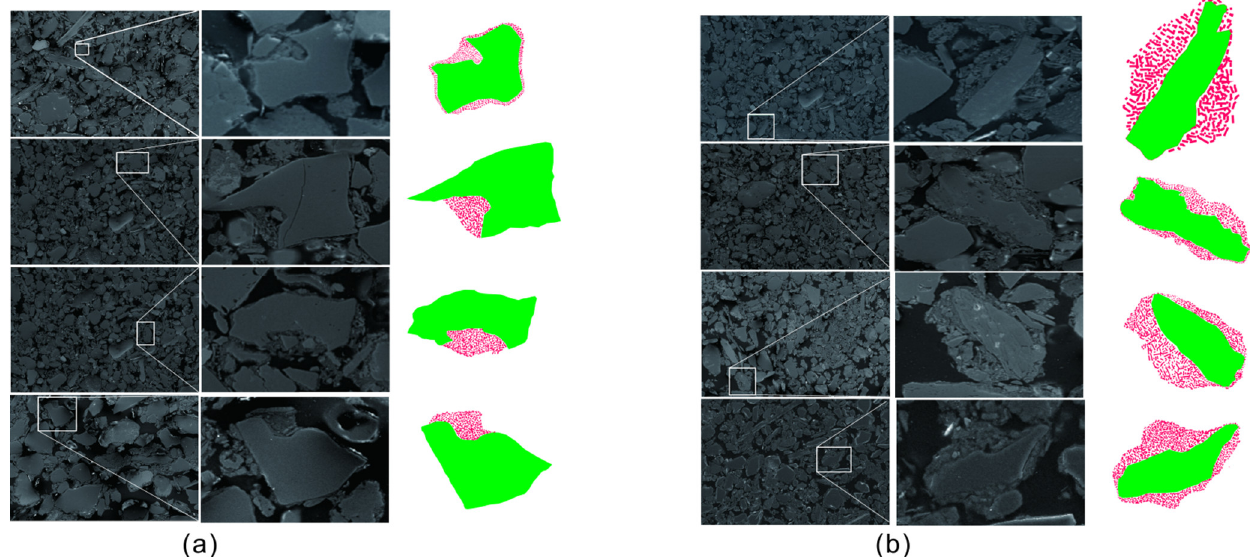
Figure 15. The conceptual model of the ( a ) filling and ( b ) adsorption effects of colloidal clay.